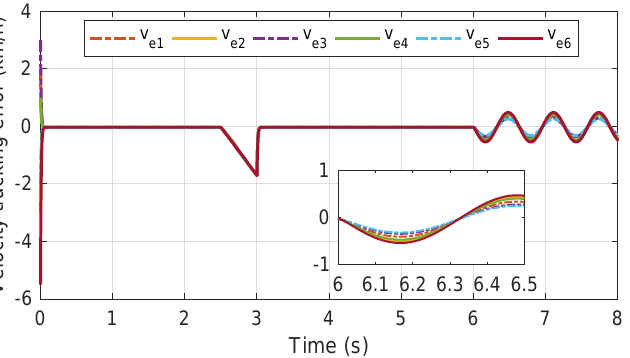
Figure 12. Velocity tracking error curve of each carriage without the anti-disturbance control compo- nent in case